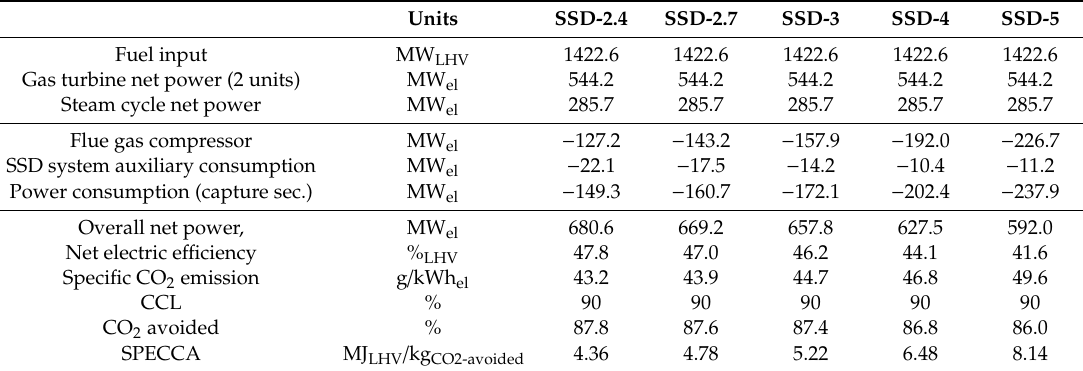
Table 20. SSD performance evaluation outcomes.